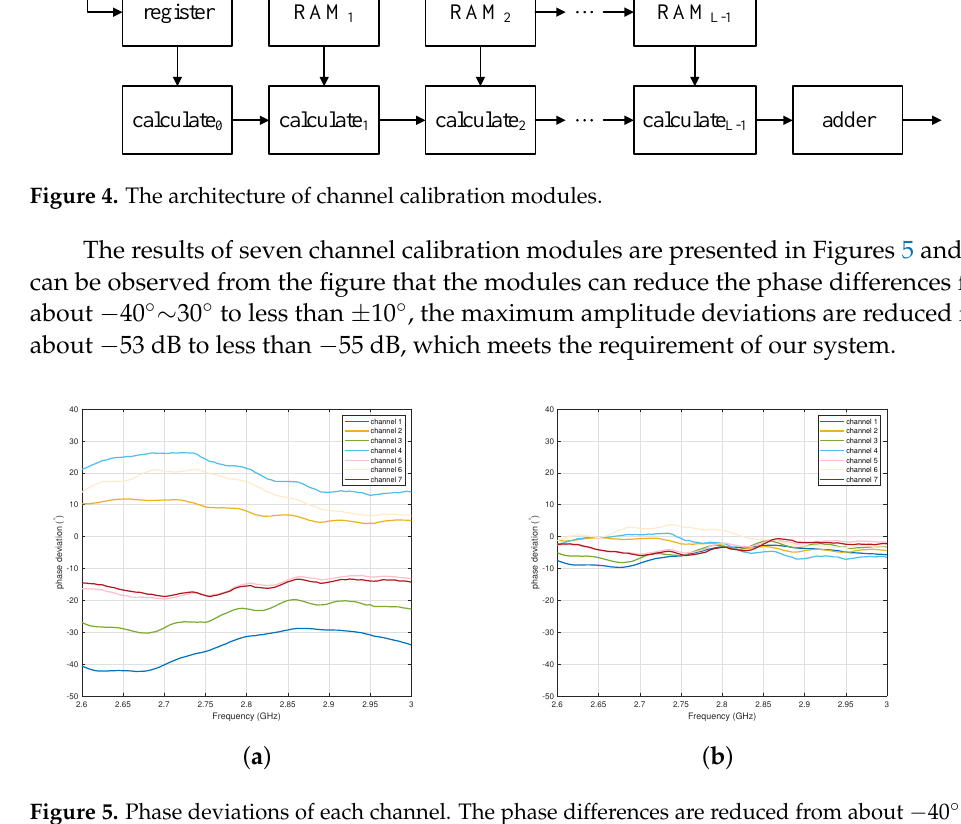
Figure 5. Phase deviations of each channel. The phase differences are reduced from about − 40 ◦ ∼ 30 ◦ to about − 10 ◦ ∼ 4 ◦ . ( a ) Phase deviations before calibration; ( b ) Phase deviations after